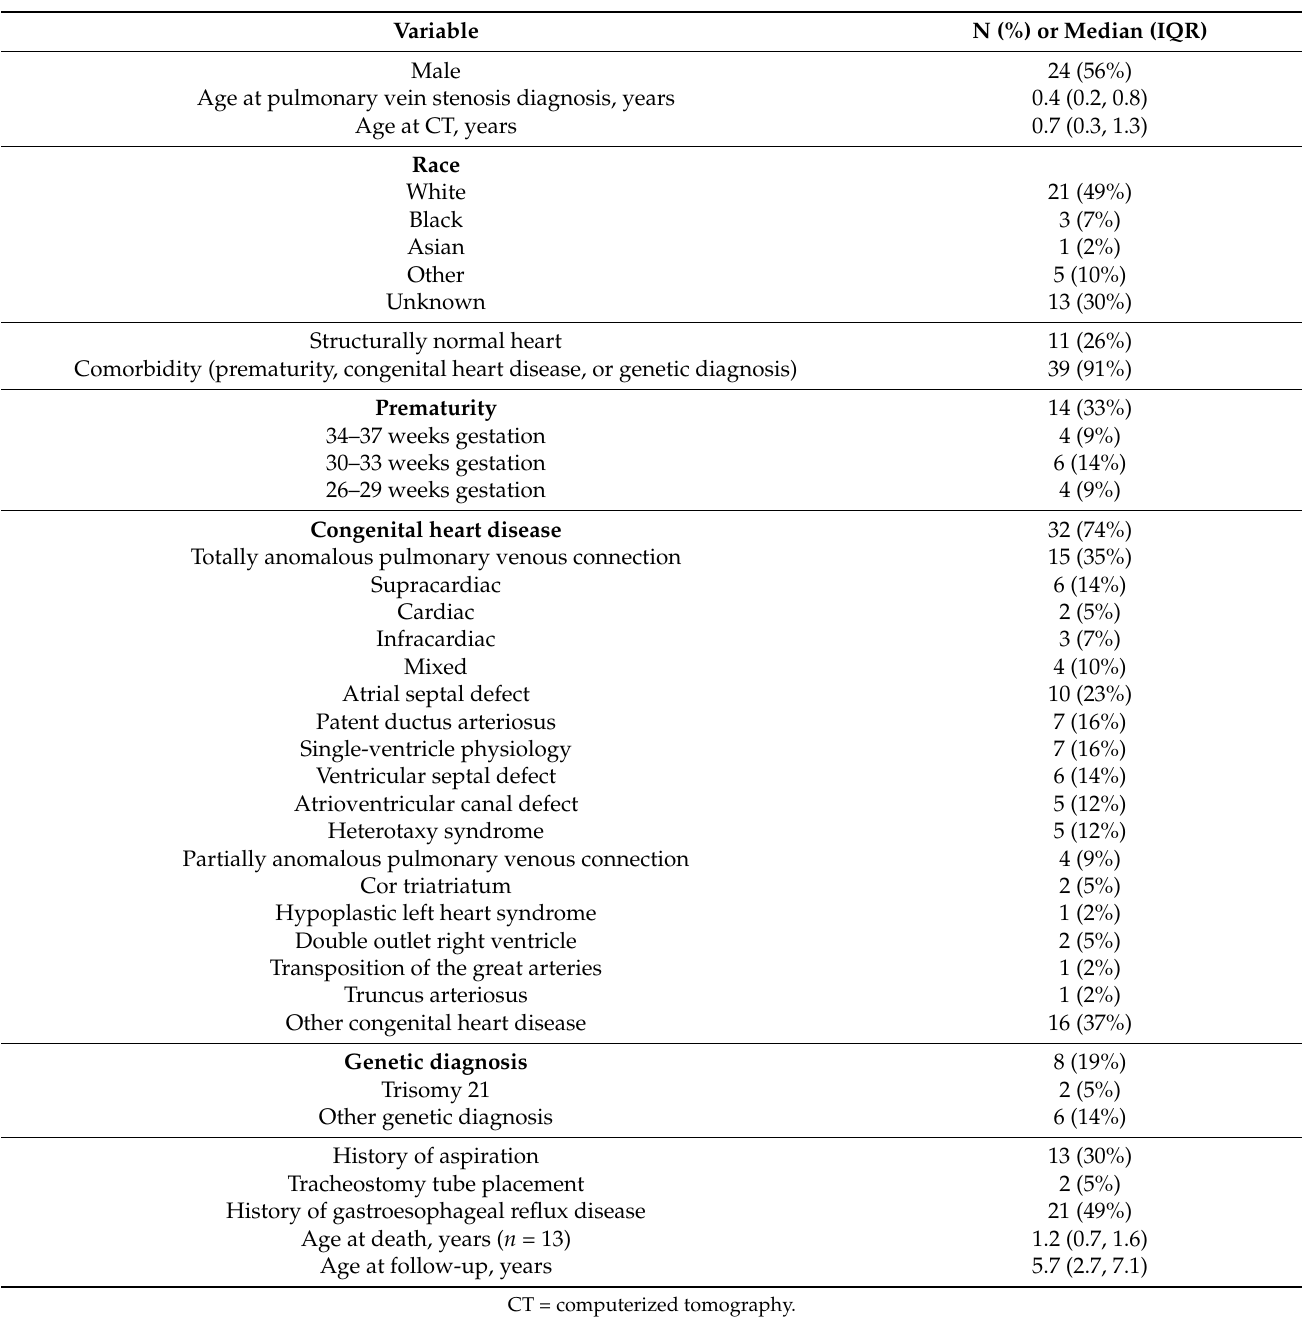
Table 1. Patient characteristics ( N =